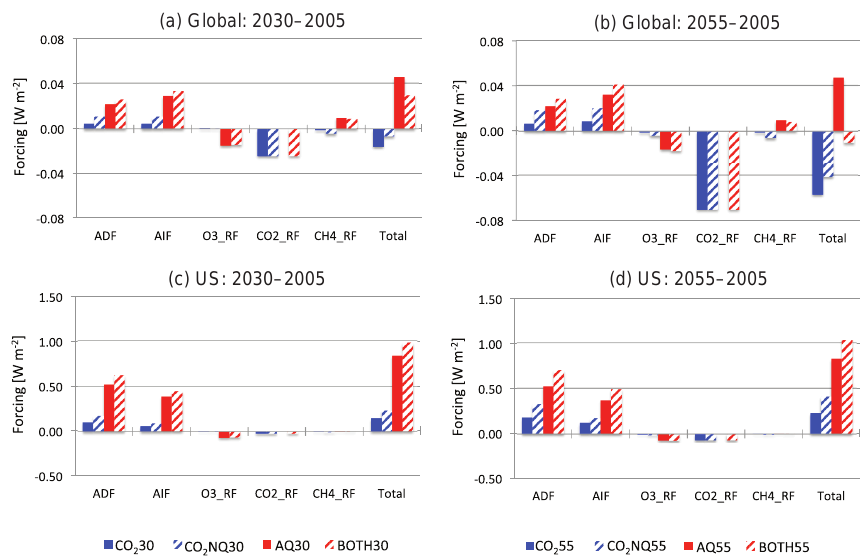
Figure 9. Impact of the air quality regulations and CO 2 reduction policy on global (a, b) and US (c, d) averaged radiative forcings in 2030 and 2055 relative to 2005. Note that BC albedo forcing is added to aerosol direct forcing (ADF). The exact value of RFs is presented in Tables S5 and S6 for global mean and US mean, respectively.